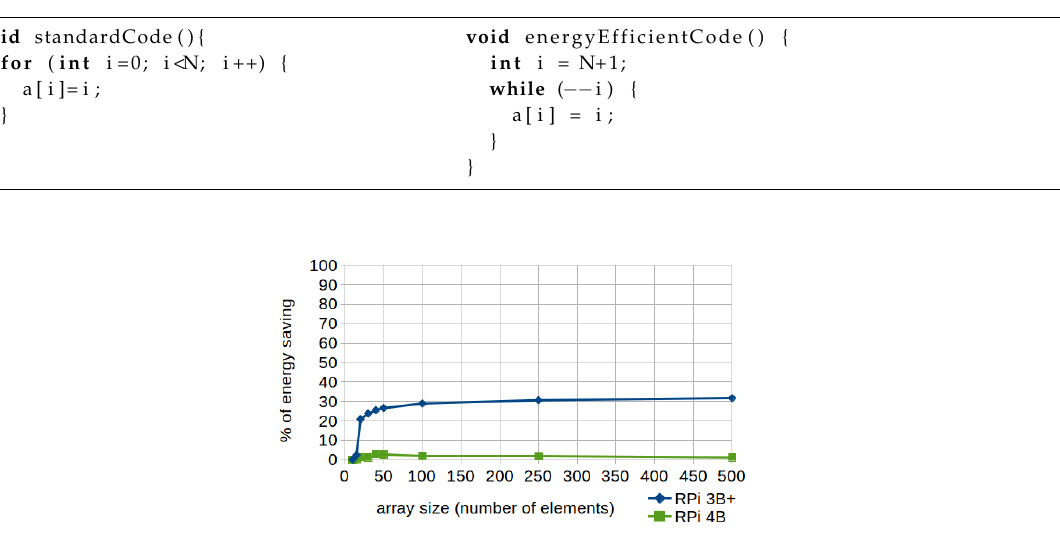
Figure 6. Loop count down. Percentages of energy saving according to the array size (number of elements) in RPi 3B+ and 4.